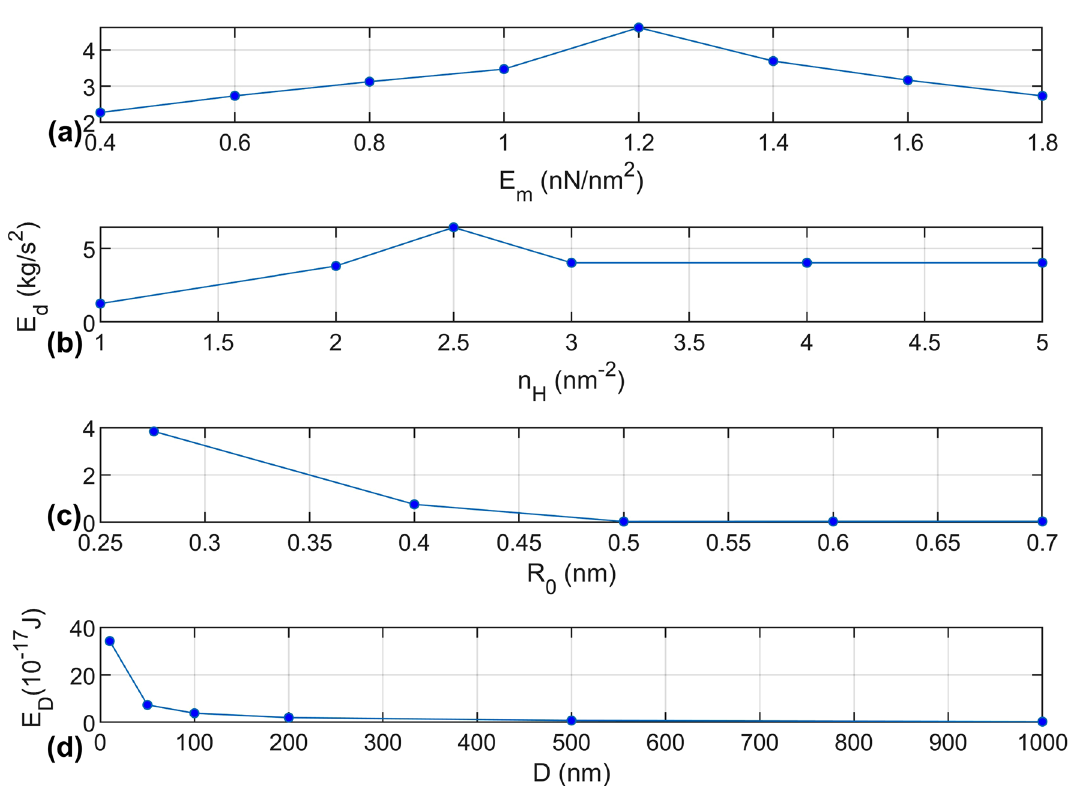
Figure 5. Energy dissipation after 3 cycles of the top material displacement (same input as in Fig. 2b) in terms of: ( a ) elastic modulus of matrix material for D = 100 nm, n H = 2 nm −2 , R 0 = 0.276 nm, E p = 145 nN/ nm 2 ; ( b ) hydrogen bonding density for D = 100 nm, R 0 = 0.276 nm, E m = 1.4 nN/nm 2 , E p = 145 nN/nm 2 ; ( c ) initial intermolecular distance for D = 100 nm, n H = 2 nm −2 , E m = 1.4 nN/nm 2 , E p = 145 nN/nm 2 ; ( d ) size of the particles for n H = 2 nm −2 , R 0 = 0.276 nm, E m = 1.4 nN/nm 2 , E p = 145 nN/nm 2 . Note that in ( a–c ), the energy dissipation is given per unit